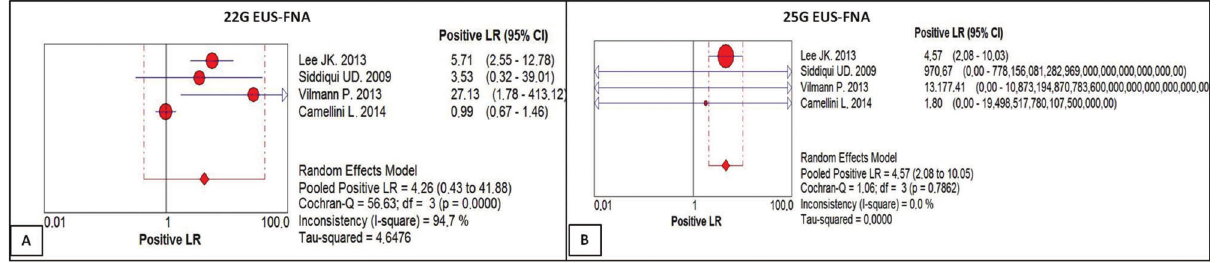
Figure 4 - (A) Positive likelihood ratio of EUS-FNA 22G. For a given prevalence of 71.61%, the positive likelihood ratio of 4.26 increased the probability 4.26-fold of the result being truly positive rather than false positive, with a post-test probability of 91.3%. (B) Positive likelihood ratio of EUS-FNA with the 25G needle. For a given prevalence of 77.25%, the positive likelihood ratio of 4.57 increased the probability 4.5-fold that the result is truly positive rather than false positive, with a post-test probability of 93.85%. to 0.15 and heterogeneity of 0.0% (Figure 5B). There was no The post-test probability was 93.85% for the 25G needle statistically significant difference between the methods. and 91.30% for the 22G needle. The area under the sROC